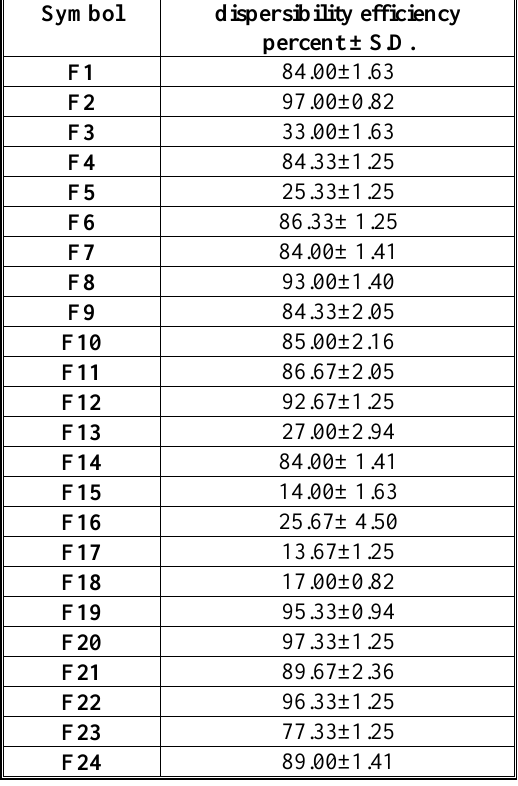
Table (3) The dispersibility percentage of